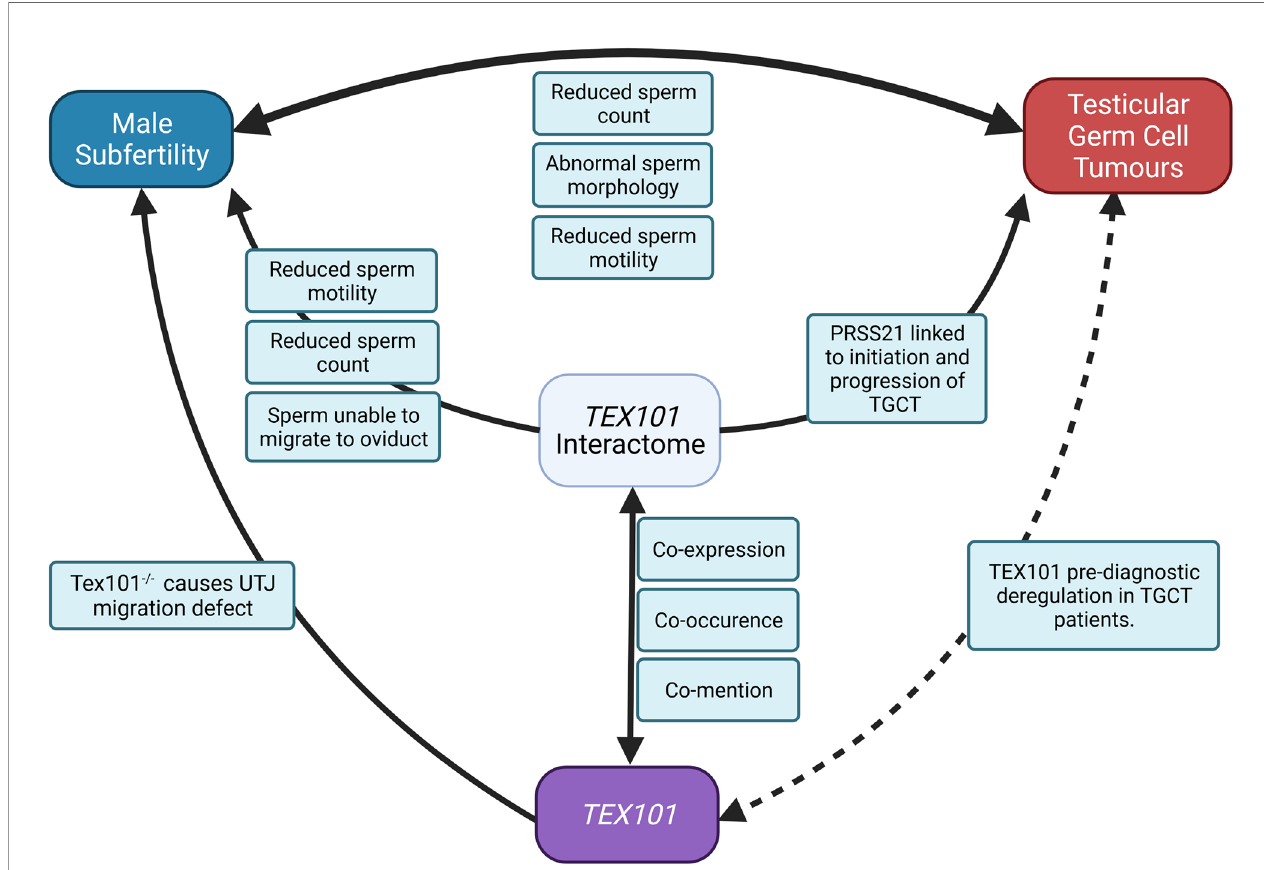
FIGURE 3 | The roles of TEX101 and its interactome in fertility and TGCT (UJT, uterine-tubal